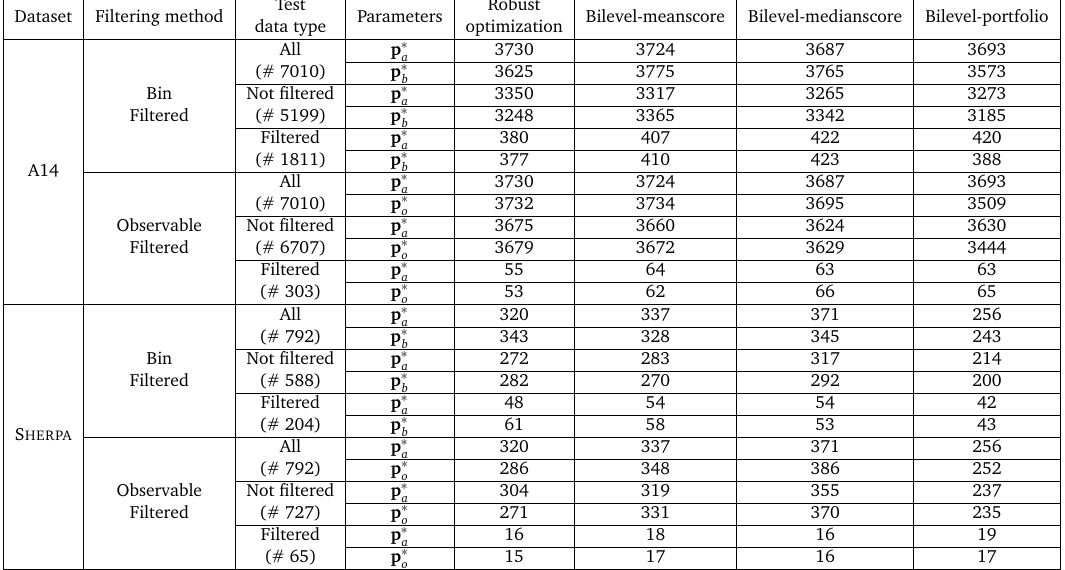
Table 8: Number of bins in the A14 and S HERPA datasets within the one σ variance